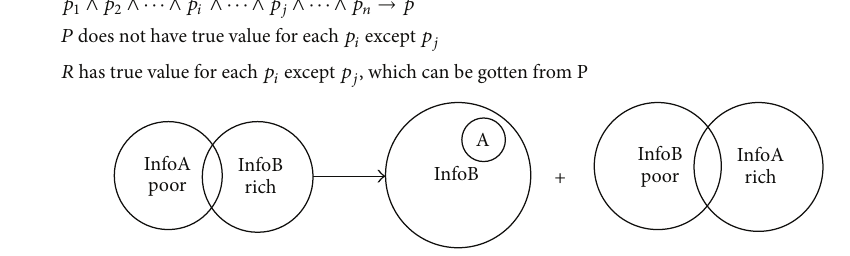
Figure 1: Role exchange between two